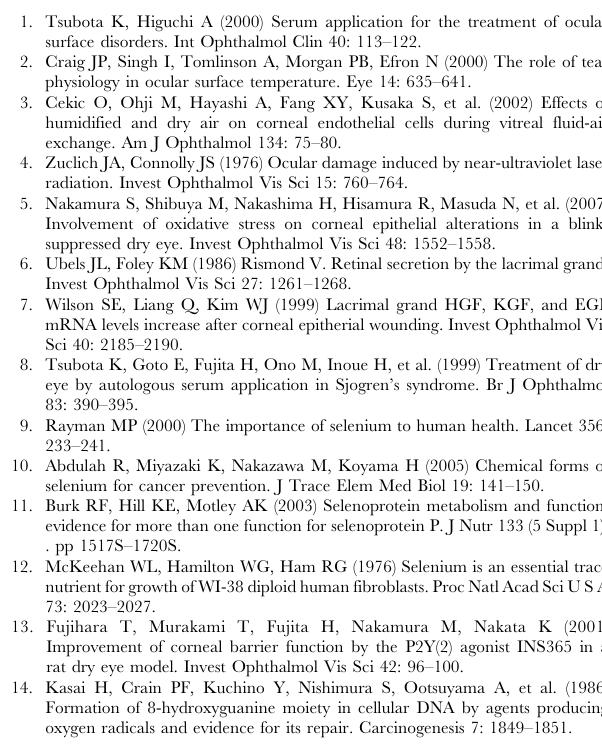
Figure S1 Identification of candidate for dry eye treatment from human plasma. a: Treatment effect of fraction 41-h on corneal epithelial erosion induced by ocular surface desiccation. Results are expressed as mean 6 S.D (n= 6). Paired Student’s t-test was used to determine the significance of differences. * indicates a significant difference from the result of PBS treatment, P , 0.05. b: Fractionation of Fraction 41-h using HiTrap Q HP chromatog- raphy. The vertical axis shows ratio of DNA fragmentation of each fraction compared with HiTrap Q HP-applied solution (Fraction 41-h). c: SDS-PAGE pattern of Fraction 31. Marker: molecular weight marker; Fr32: Fraction 32. Found at: doi:10.1371/journal.pone.0009911.s002 (1.71 MB